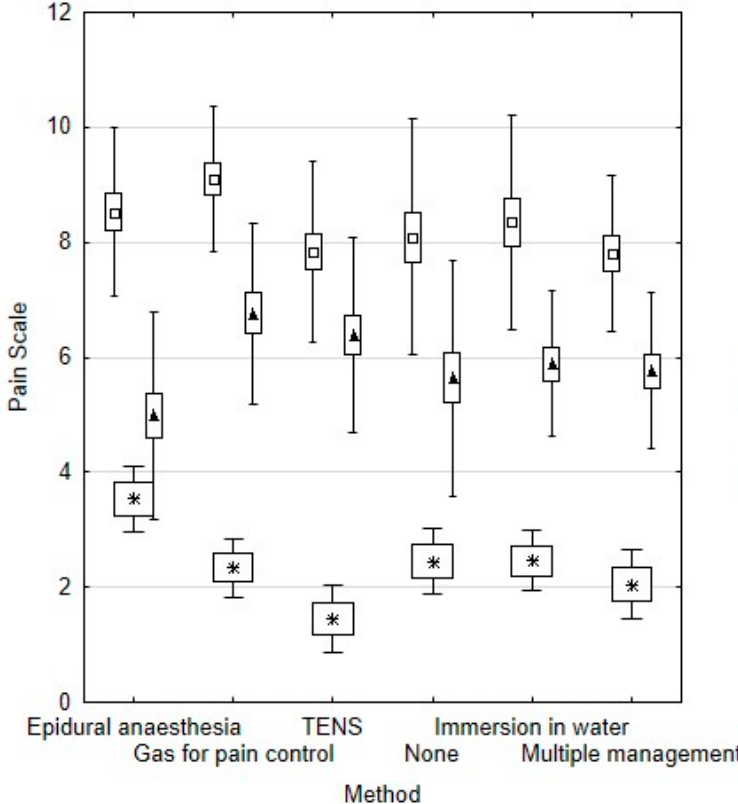
Figure 1. Association between prediction and mean value of labour pain intensity.